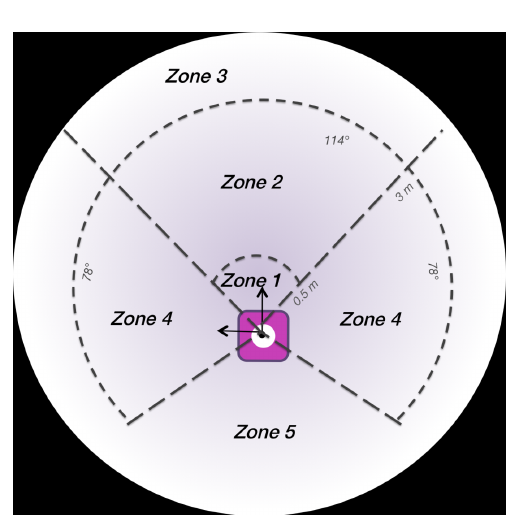
Figure 3. Zones defined for human detectors data fusion in robot